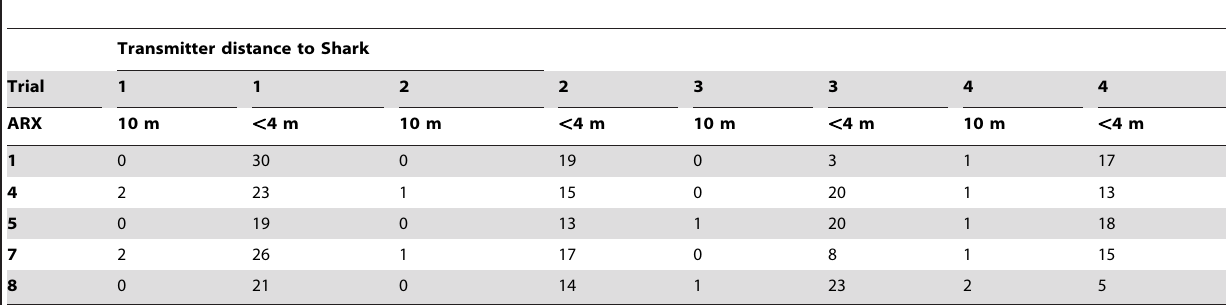
Table 1. Validation tests of detection frequency (number of received transmissions) as a function of distance between receivers and transmitters during on-shark trials (ARX receivers, N = 5; Trials, N =